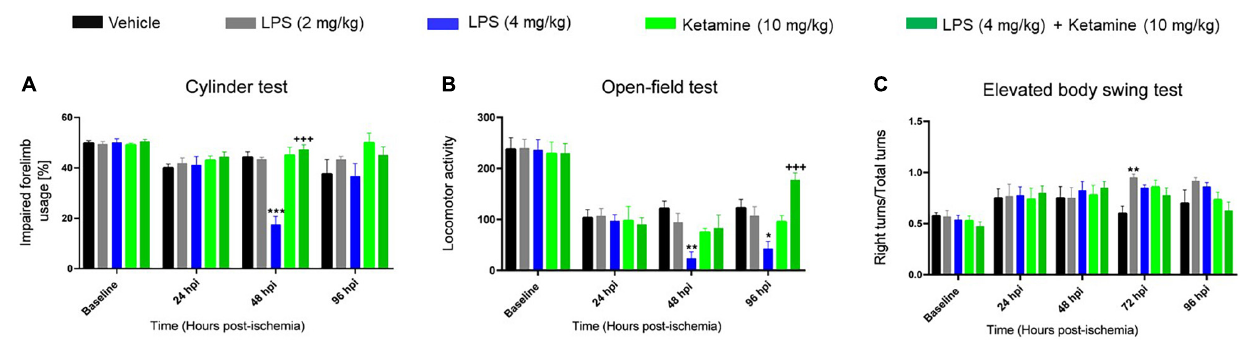
FIGURE 2 | Effects of LPS-induced sepsis and ketamine on post-ischemic motor-coordination deficits. Motor-coordination performance evaluated by (A) cylinder, (B) open-field, and (C) elevated body swing tests of mice exposed to transient MCAO followed by delivery of vehicle or LPS (2 or 4 mg/kg) at 24 hpi. 30 min later, vehicle or ketamine (10 mg/kg) was injected in mice receiving vehicle or LPS (4 mg/kg). Note that LPS-induced sepsis (4 mg/kg) significantly impaired motor-coordination and spontaneous locomotor activity evaluated by the cylinder and open-field tests. Ketamine reversed the LPS-induced motor-coordination deficits, while ketamine alone had no effect. Data are mean ± SEM values ( n = 6 animals/group). * p < 0.05; ** P < 0.01; *** P < 0.001 compared with ischemic vehicle; +++ P < 0.001 compared with ischemic LPS (4